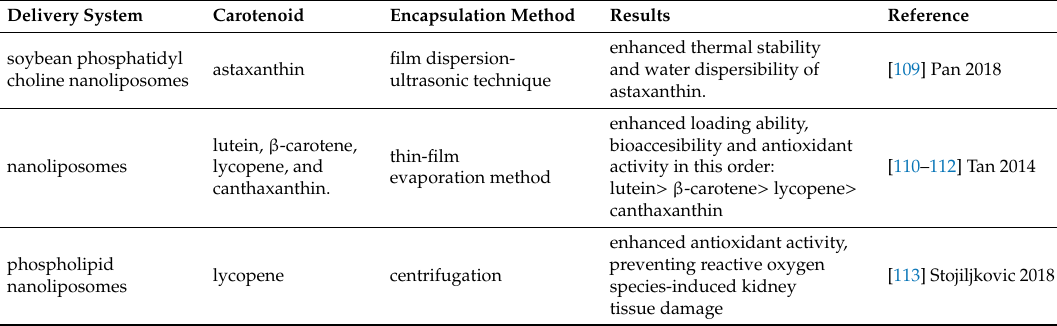
Table 4. Nanoliposomes as delivery system for carotenoid